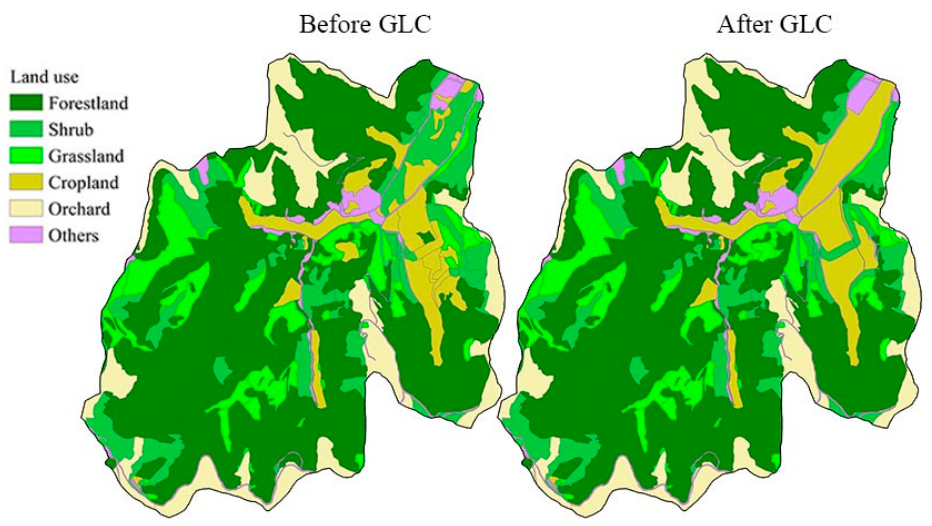
Figure 2. Land use in Xingshuyaozi watershed before GLC (in 2013) and after GLC (in 2019).